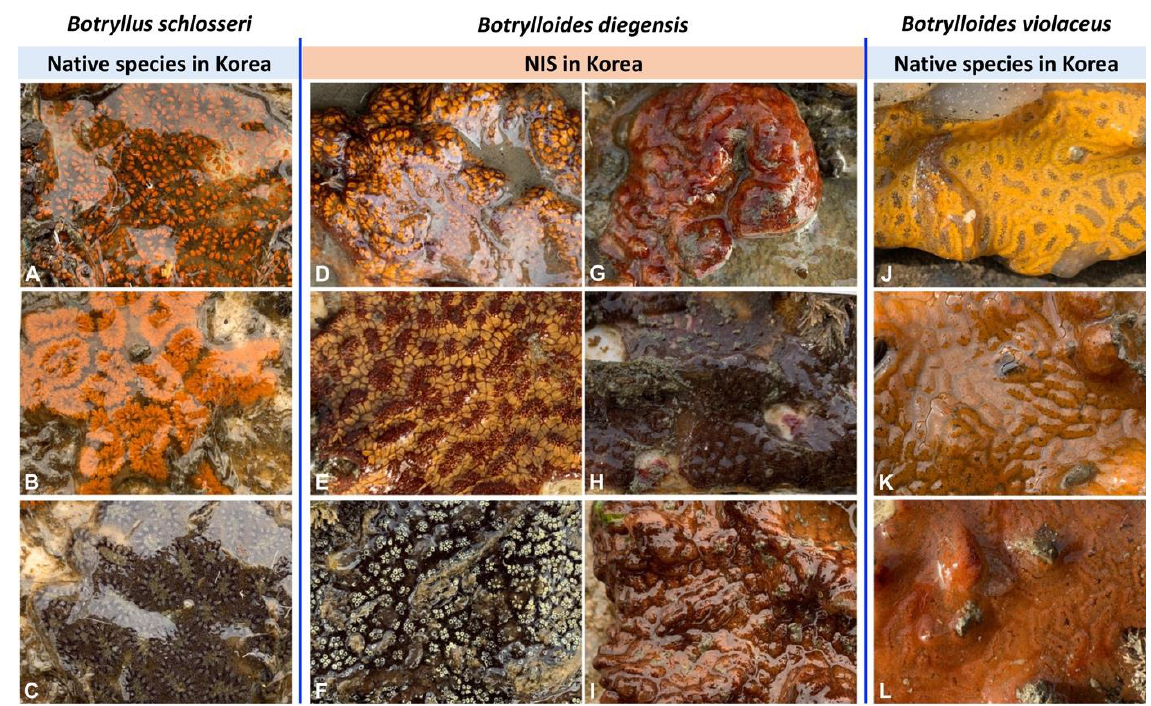
Figure 2. Various color and morphotypes of Botryllus schlosseri ( A – C ) , Botrylloides diegensis ( D – I ), and B. violaceus ( J – L ) in South Korea.